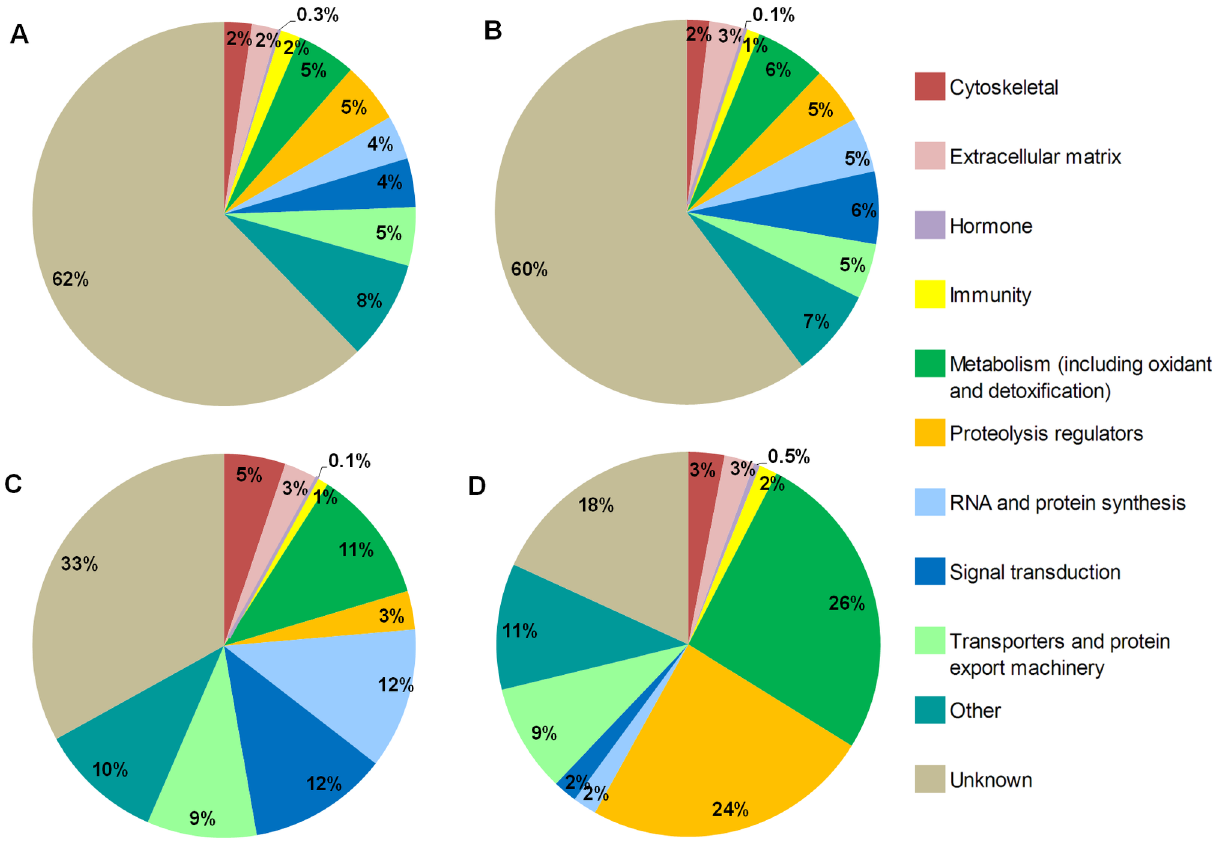
Figure 1. Functional categories of Aedesalbopictus lower reproductive tract transcripts and seminal fluid proteins. Numbers indicate the percent of transcripts associated with the functional category. A. Transcripts found only in males (accessory glands and seminal vesicles; 3,980 total); B. Transcripts found only in females (lower reproductive tract; 7,576 total); C. Transcripts found in both males and females (17,947 total); D. Seminal fluid proteins (198